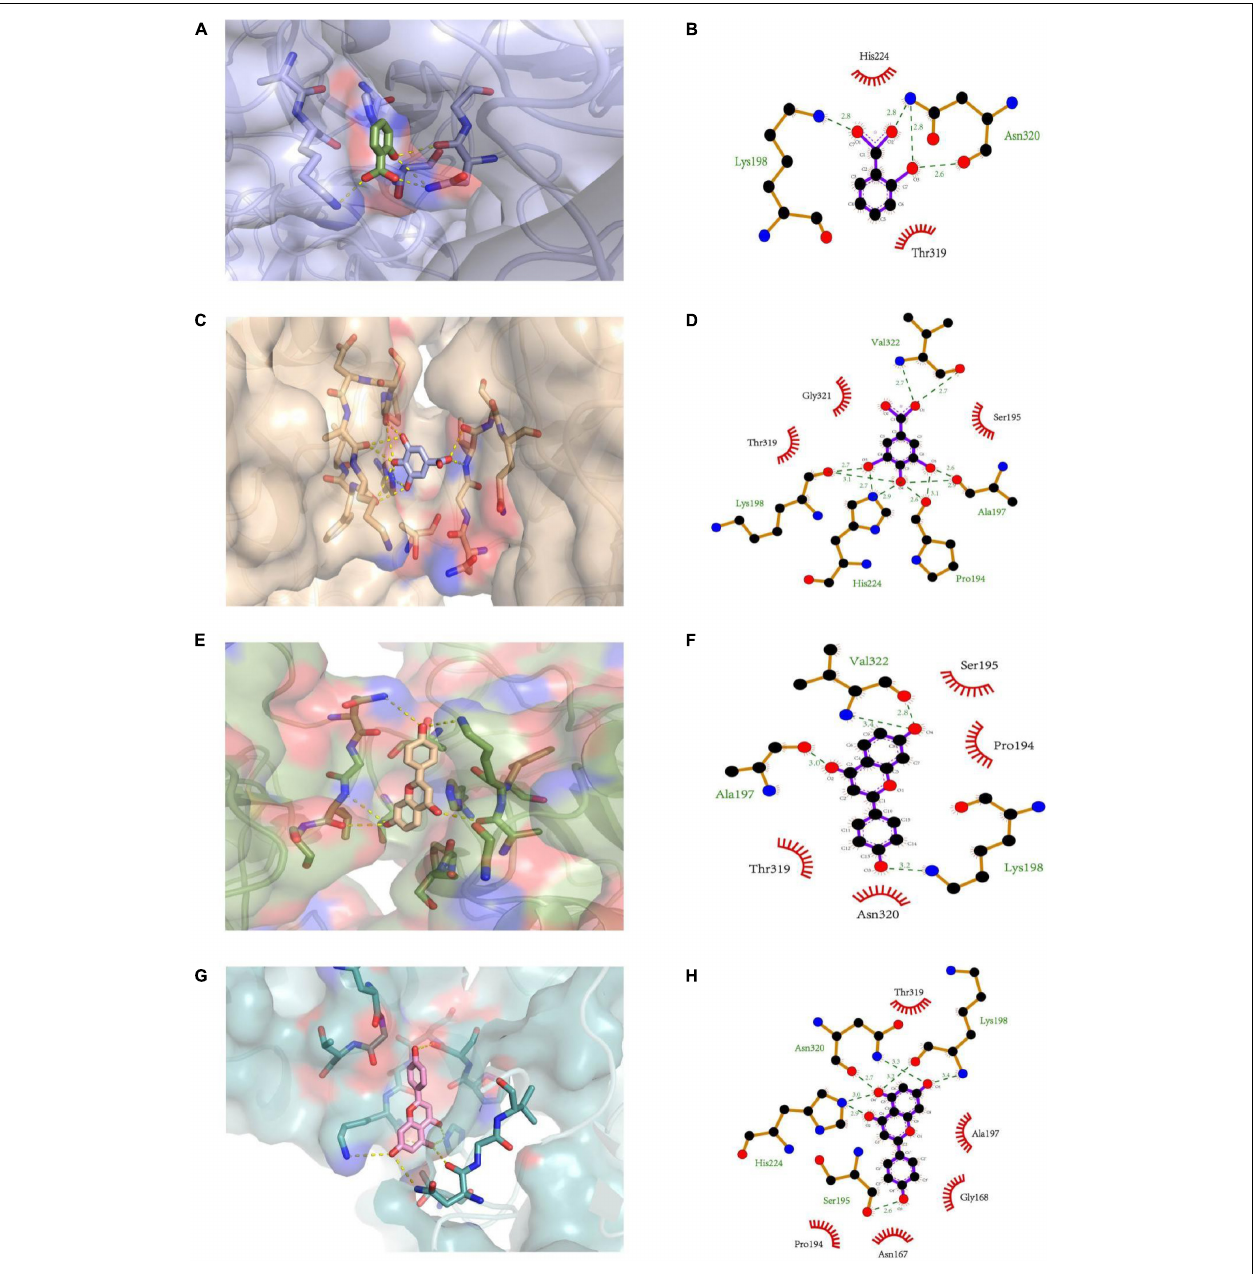
FIGURE 4 | The 3D structure of (A) salicylic acid, (C) gallic acid, (E) liquiritigenin, and (G) naringenin docking with PL, respectively. The 2D schematic diagram of (B) salicylic acid, (D) gallic acid, (F) liquiritigenin, and (H) naringenin interacting with PL, respectively.